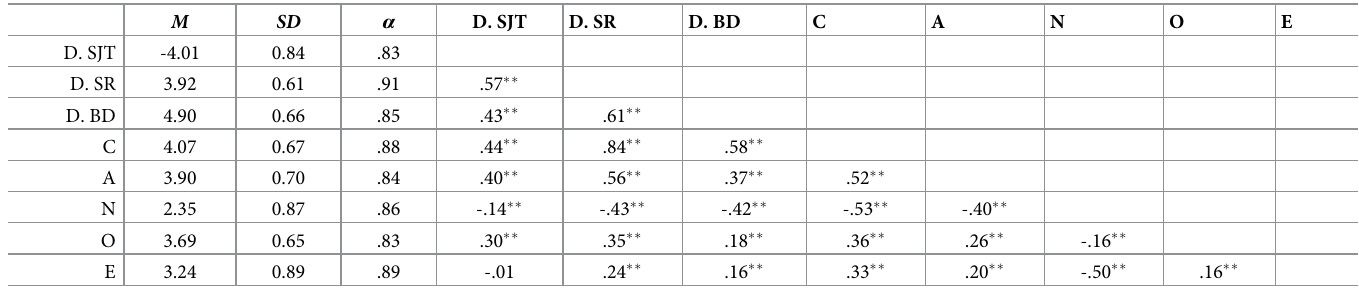
Table 3. Correlations of the dependability and BFI scales.